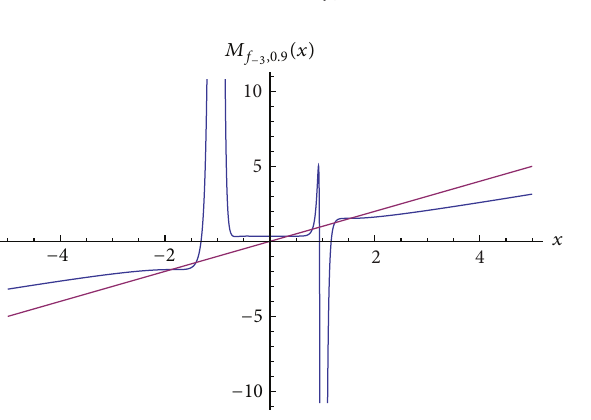
̃𝑀 1.0,𝑓 + as a circle map.